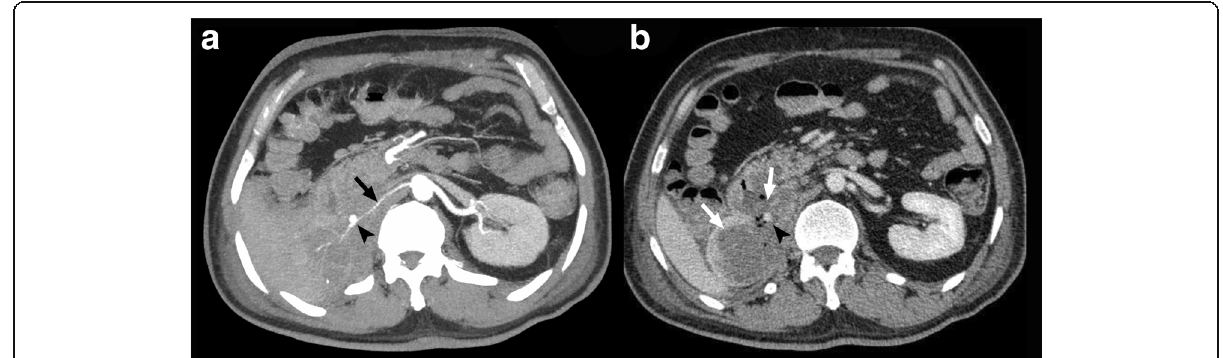
Fig. 1 Maximum intensity projection (MIP) reconstruction ( a ) and thin slice ( b ) images of contrast-enhanced abdominal CT scan in the arterial phase show a small right renal artery (arrow in a ) with a pseudoaneurysm (arrowhead in a and b ), and a hypo-enhancing ill-defined mass originating from the right kidney (asterisk in b ). There is tumoral erosion and invasion into the adjacent duodenum and remaining renal tissue (white arrows in b )